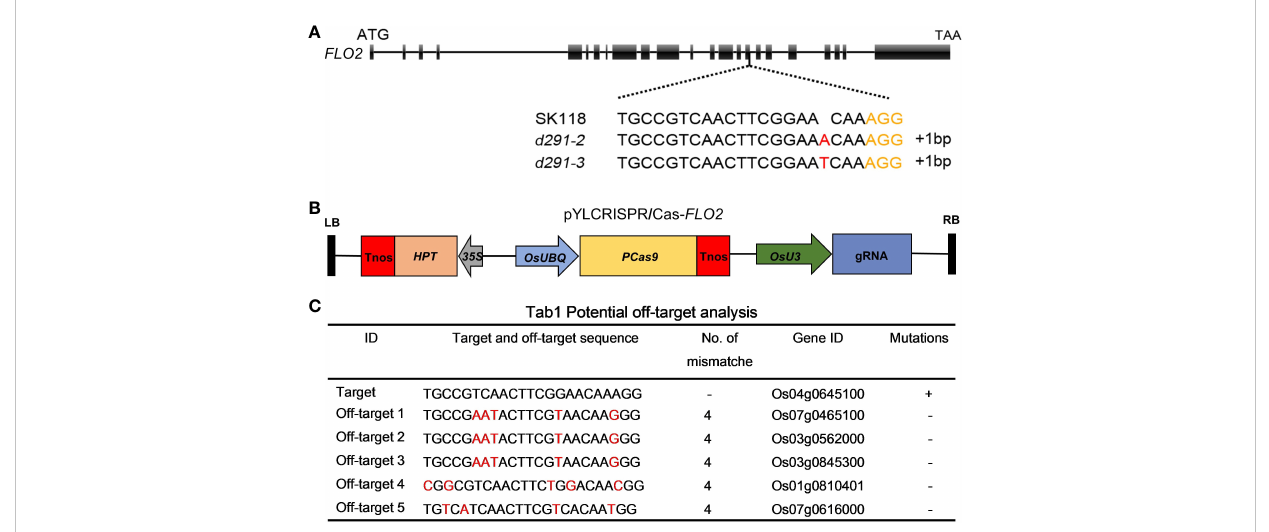
FIGURE 1 CRISPR/Cas9-induced mutations in the FLOURY ENDOSPERM 2 genes. (A) Schematic of the FLOURY ENDOSPERM 2 gene structures and target sites. Exons and introns are indicated with black rectangles and black lines, respectively. The spacer and PAM sequences were marked in black and orange. (B) The expression vector of pYLCRISPR/Cas9- Flo2 . The expression of Cas9 is driven by the maize ubiquitin promoter ( OsUBQ ); the expression of the sgRNA scaffold is driven by the rice OsU3 small nuclear RNA promoter; the expression of hygromycin ( HPT ) is driven by CaMV35S promoter. Tnos, the terminator; LB and RB, left border and right border, respectively. (C) Potential miss analysis. Red fonts indicate different